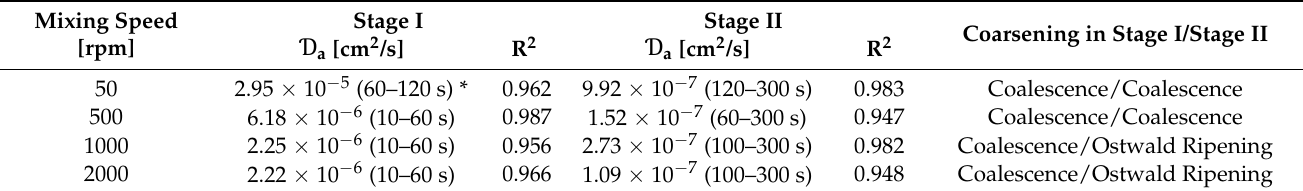
Table 3. Results of the fitting procedure caused by Equation (3).